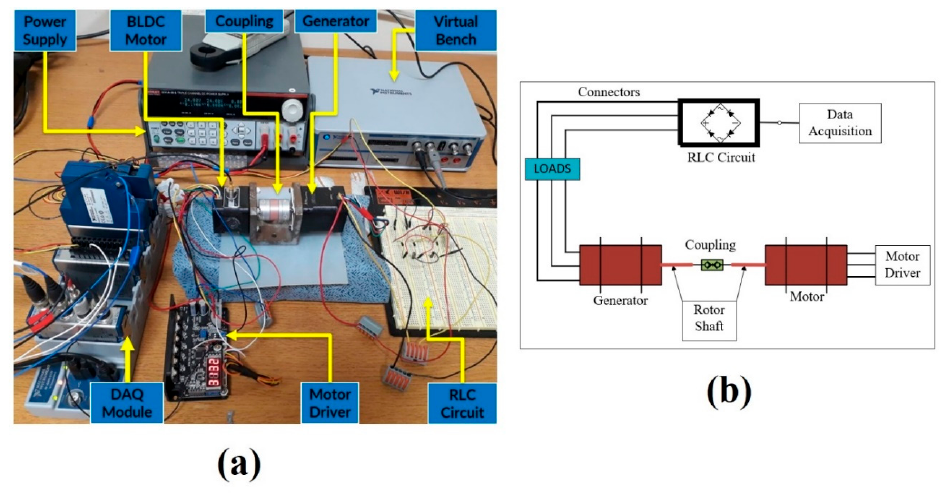
Figure 5. Test rig setup. ( a ) Reat test bench photo, ( b ) Schematic diagram of the test bench setup. Table 1. BLDC motor